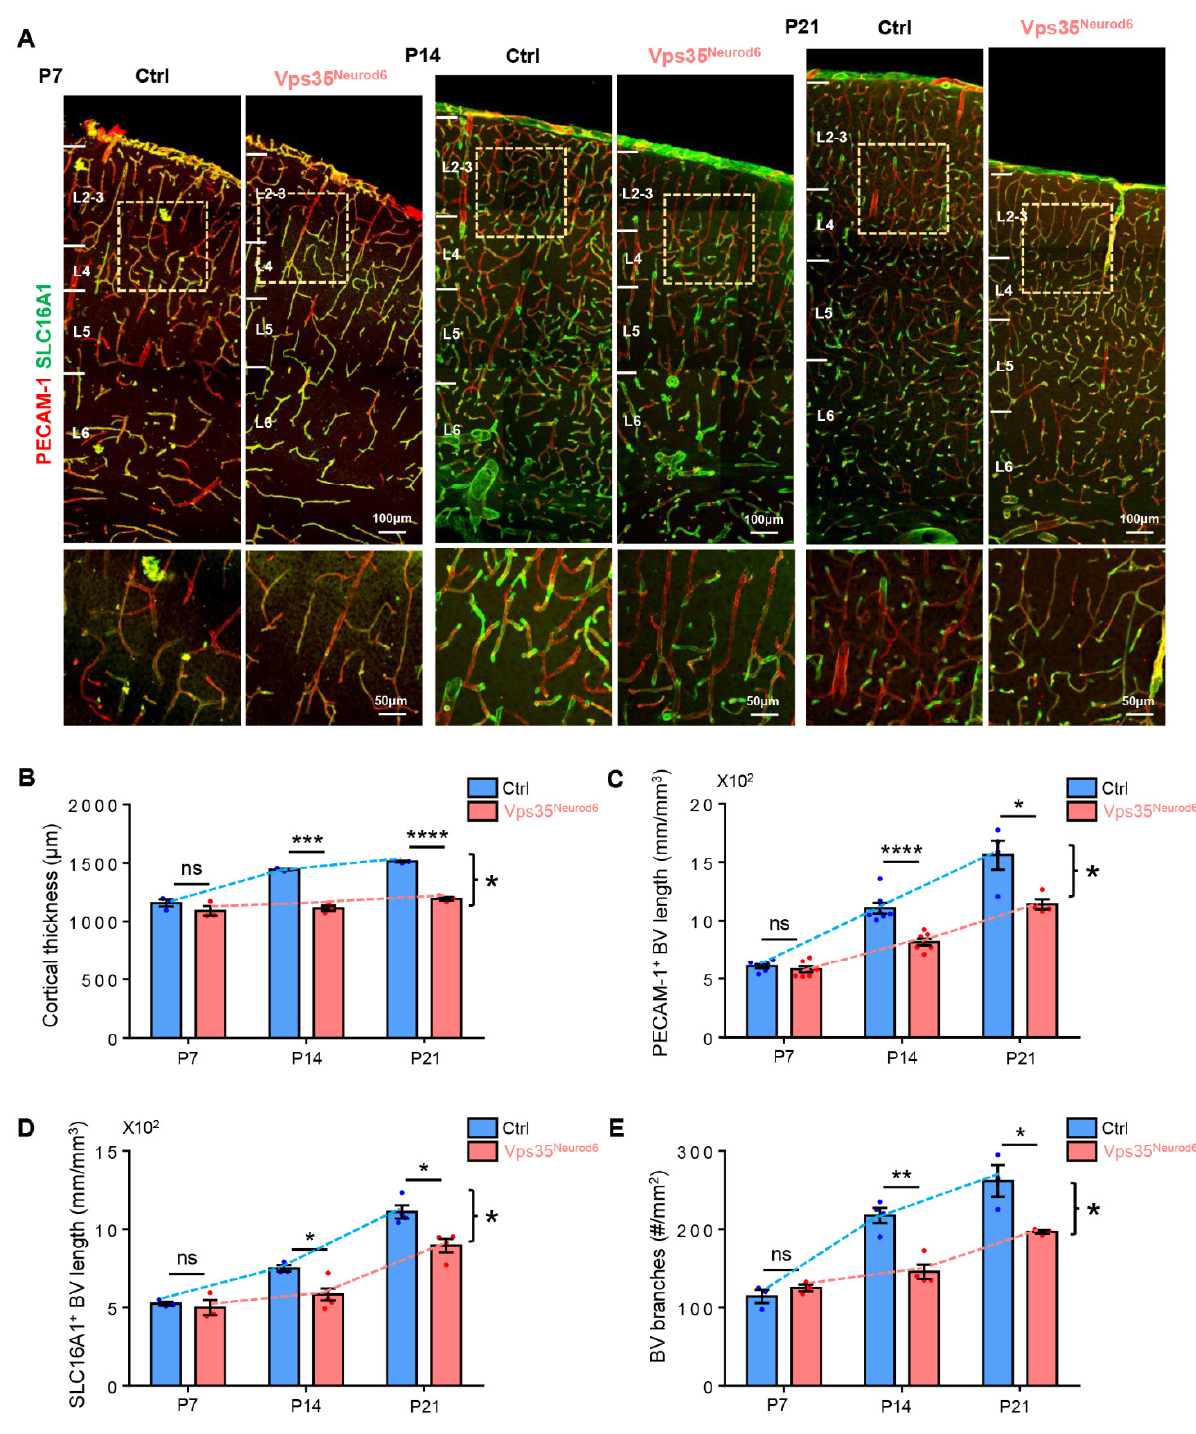
Figure 3. Reduced PECAM-1 + and SLC16A1 + vessels in Vps35 Neurod6 cortex at P14 and P21. ( A ) Representative images of immunostaining analysis using indicated antibodies in P7, P14, and P21 neocortical sections from control and Vps35 Neurod6 mice. Higher-magnification images of the boxed regions are shown in lower panels. ( B ) Quantification analysis revealed an age-dependent reduction in cortical thickness of Vps35 Neurod6 mice at P14/P21 (n = 3~4 mice per group; two-tailed unpaired t test). ( C ) Quantification of PECAM-1 + vessel length at indicated age (n = 3~4 mice per group; two-tailed unpaired t test). ( D ) Quantification of SLC16A1 + vessel length at indicated age (n = 3~4 mice per group; two-tailed unpaired t test). ( E ) Quantification of BV branches at indicated age (n = 3~4 mice per group; two-tailed unpaired t test). Scale bars as indicated in each panel. Individual data